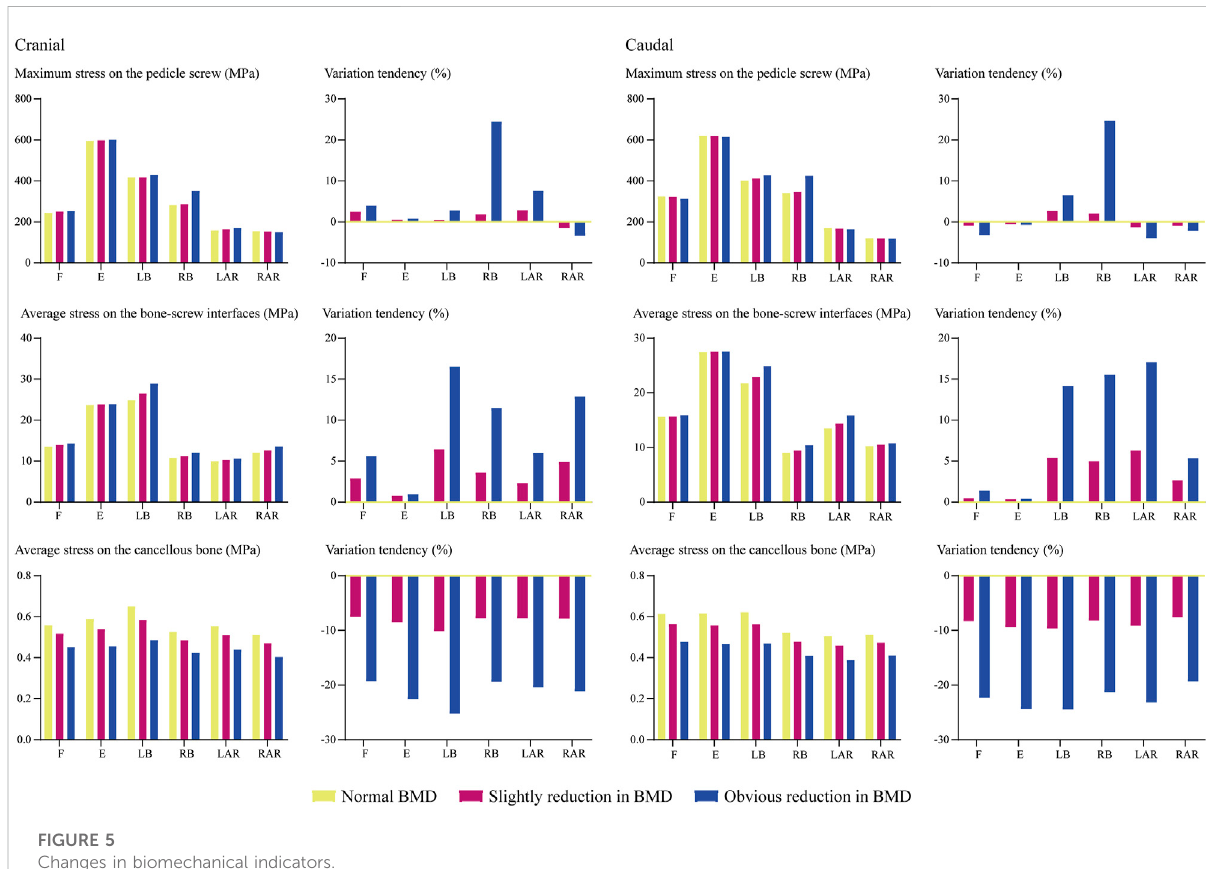
FIGURE 5 Changes in biomechanical